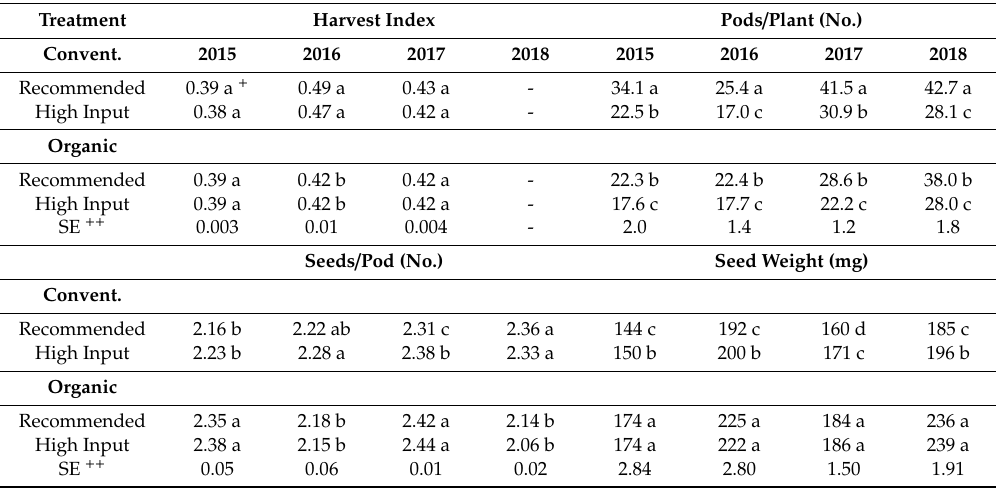
Table 7. Harvest index, pods / plant, seeds / pod and seed weight of soybean in 2015, 2016, 2017 and 2018 under conventional and organic farming systems with recommended and high input management at a University Research Farm in central New York, USA. Treatment Harvest Index Pods / Plant (No.)